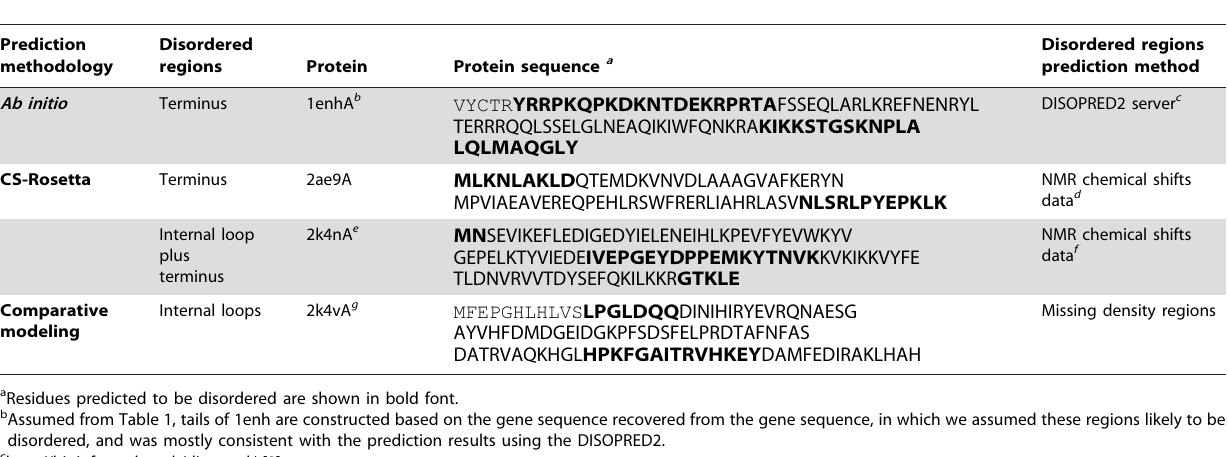
Table 4. Test cases for 2 nd